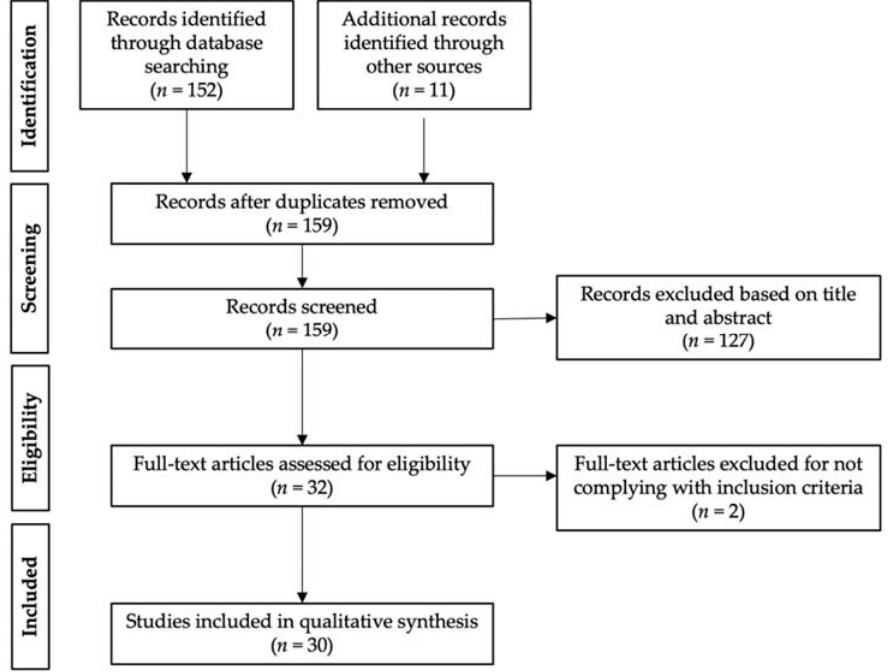
Figure 3. Schematic summary of the PRISMA literature search.